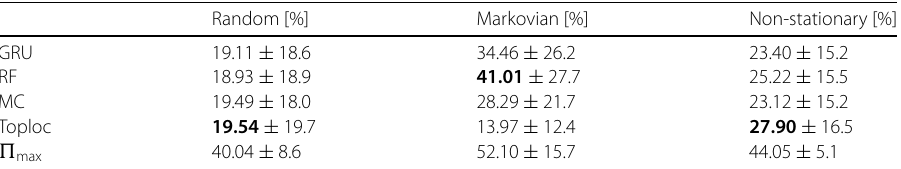
Table 1 An average accuracy of four prediction algorithms and theoretical upper bound of predictability calculated for the three types of synthetic sequences Random [%] Markovian [%] Non-stationary [%] GRU 19.11 ± 18.6 34.46 ± 26.2 23.40 ± 15.2 RF 18.93 ± 18.9 41.01 ± 27.7 25.22 ± 15.5 19.49 ± 18.0 28.29 ± 21.7 23.12 ± 15.2 Toploc 19.54 ± 19.7 13.97 ± 12.4 (cid:6) max 44.05 ± 5.1